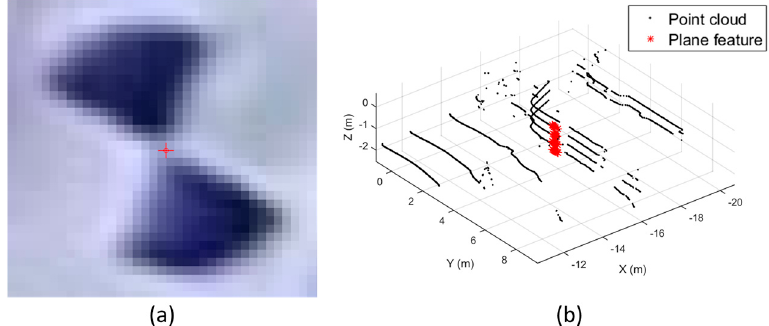
Figure 6. Example of reference feature extraction: ( a ) point feature extracted from image; ( b ) plane feature extracted from mobile laser scanning data.